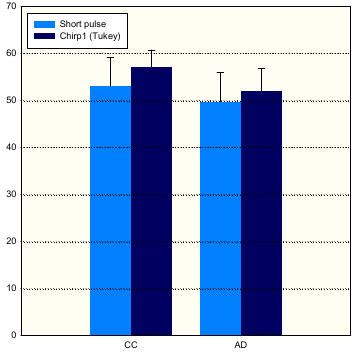
Figure 21. Elastographic contrast ‐ to ‐ noise ratio (CNRe) of phantom.